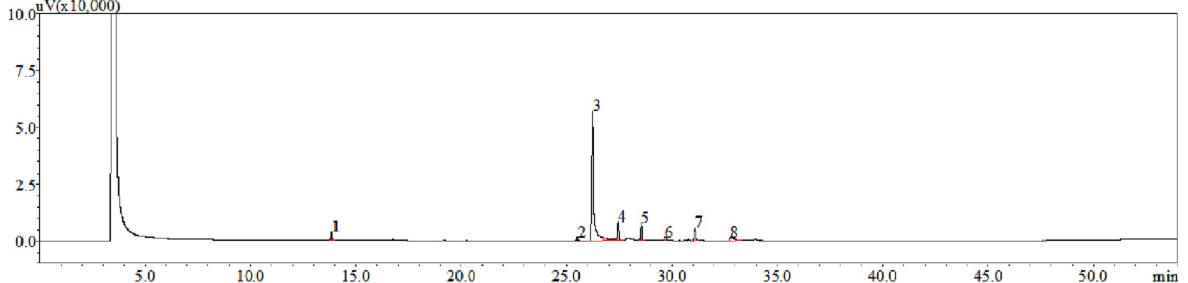
Figure 2. Chromatogram (CG-DIC) of essential oil from leaves of Ocimum